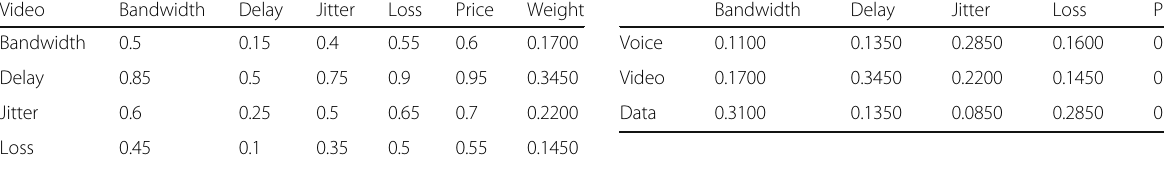
Table 8 Fuzzy consistent matrix and weights for video application Video